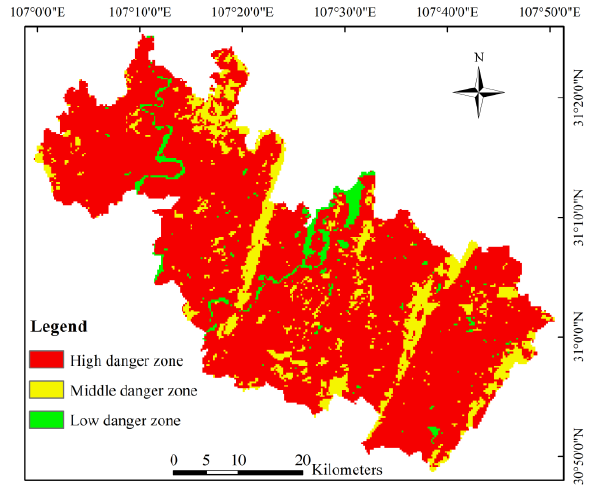
Figure 8. Potential hazard zone divided according to vegetation coverage